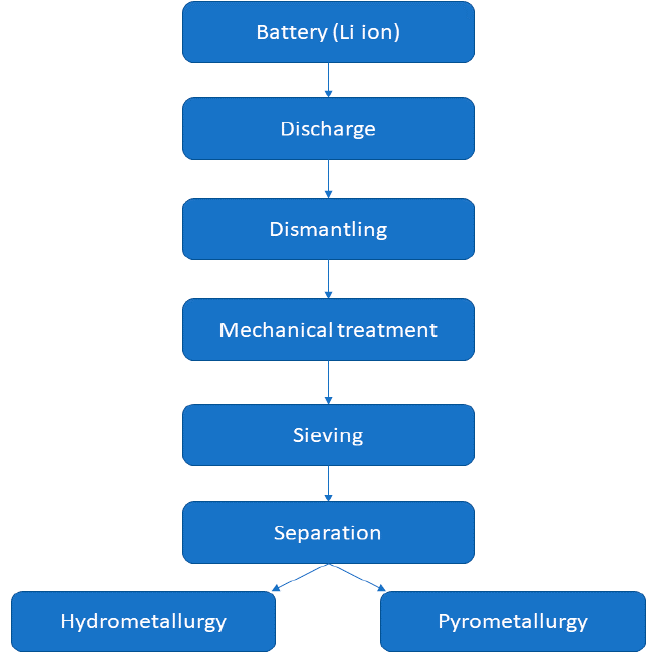
Figure 11. The pretreatment steps for a lithium-ion battery [103].